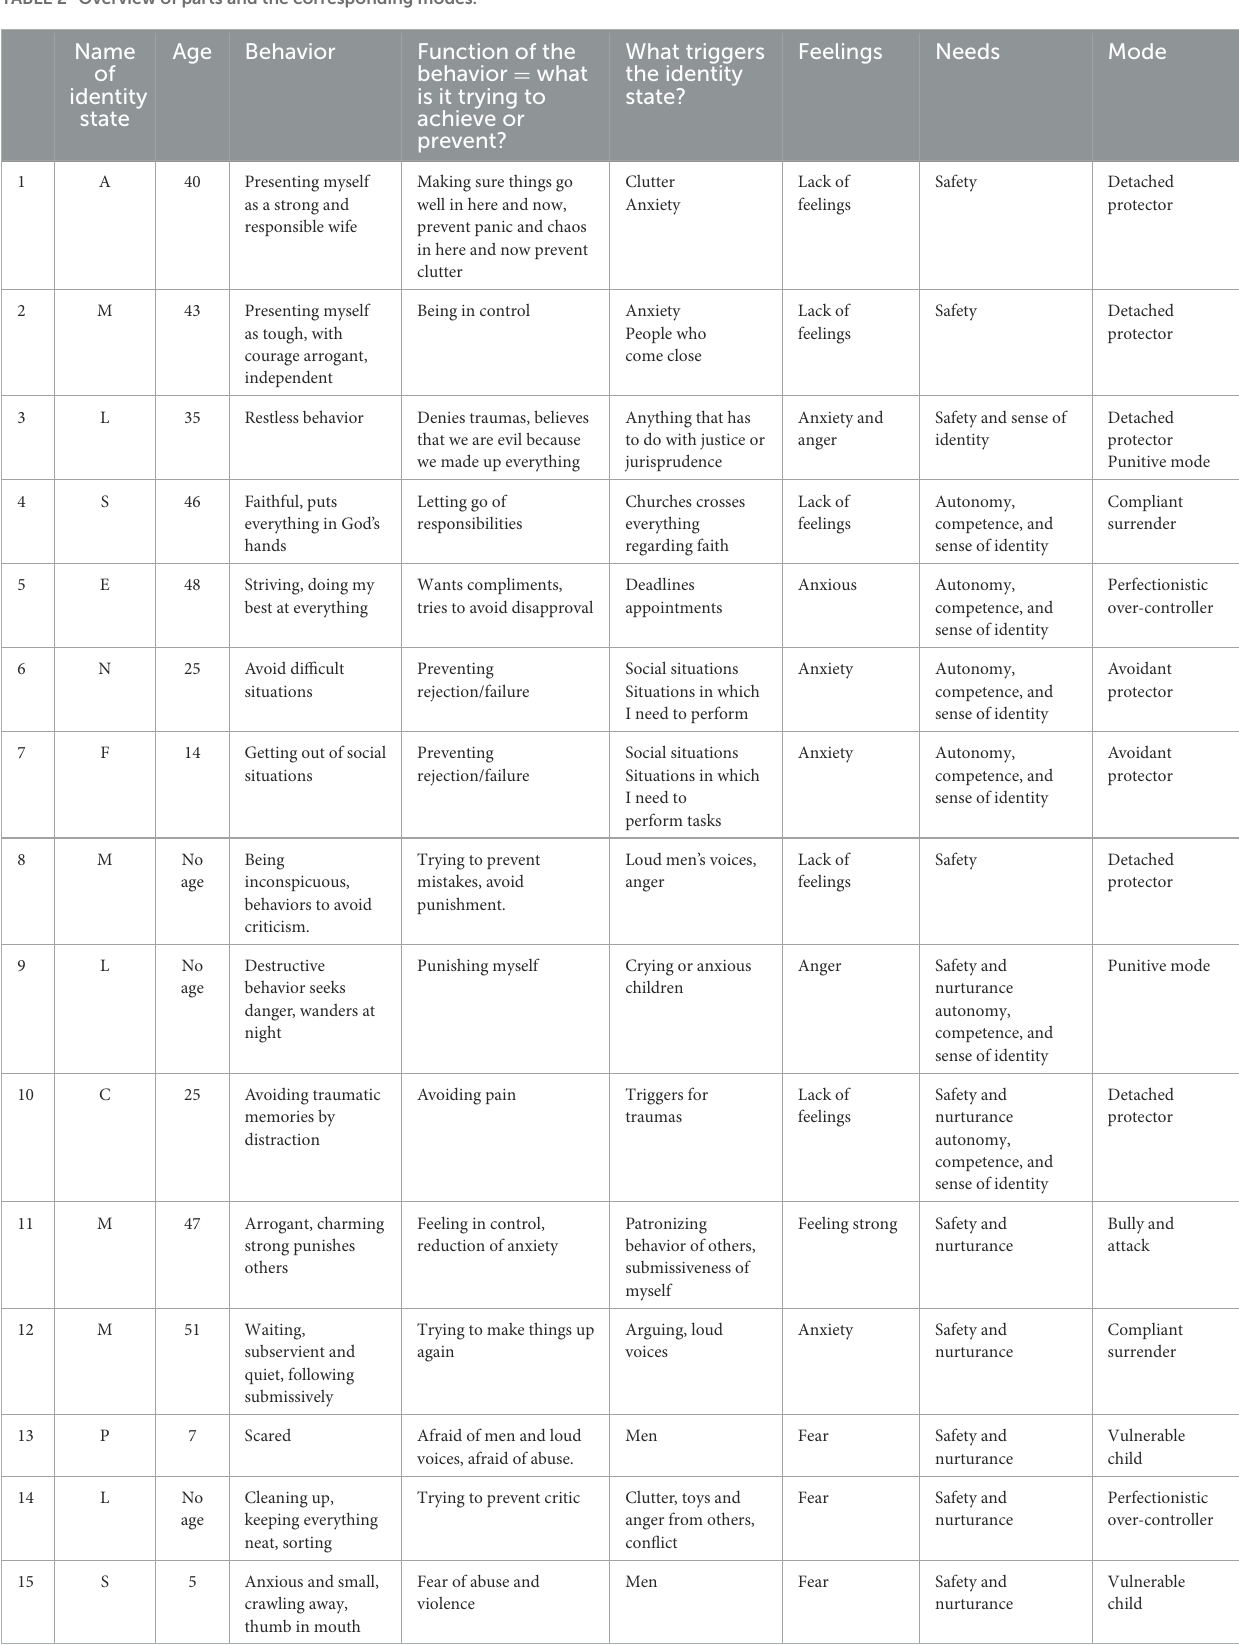
TABLE 2 Overview of parts and the corresponding modes. Name